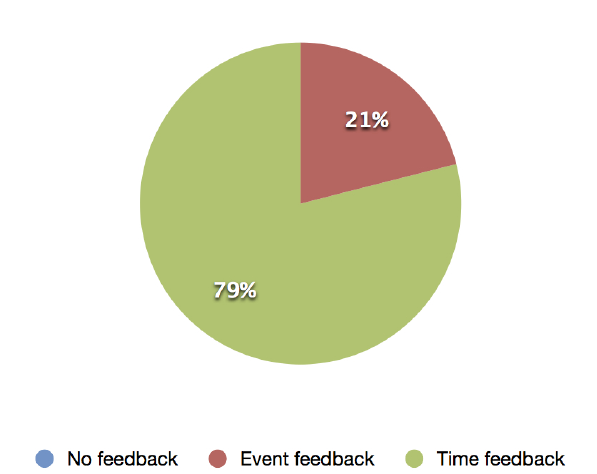
Figure 3: Participant responses to forced choice question in which they were asked to select there preferred